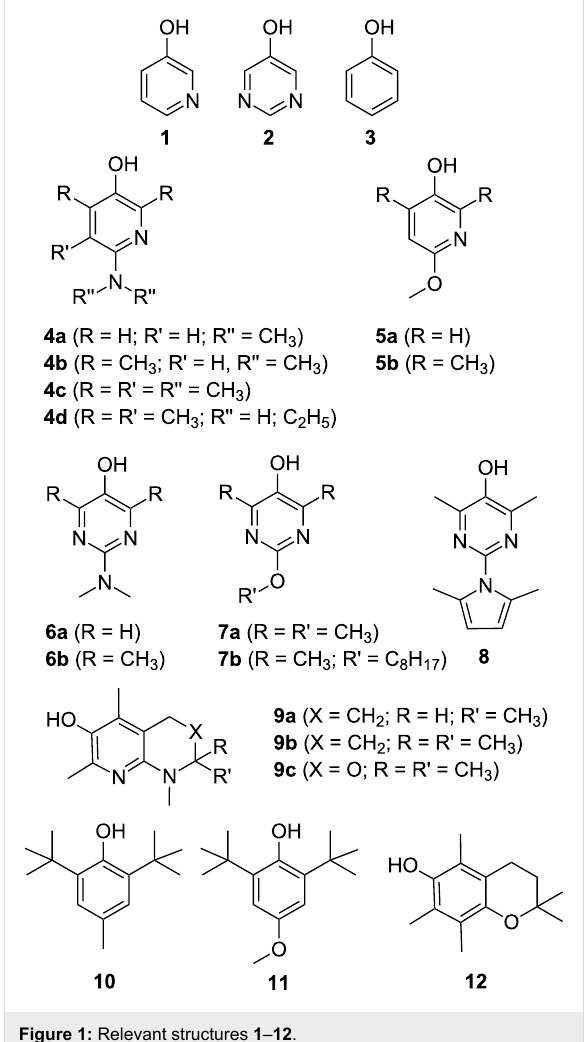
Figure 1: Relevant structures 1 – 12